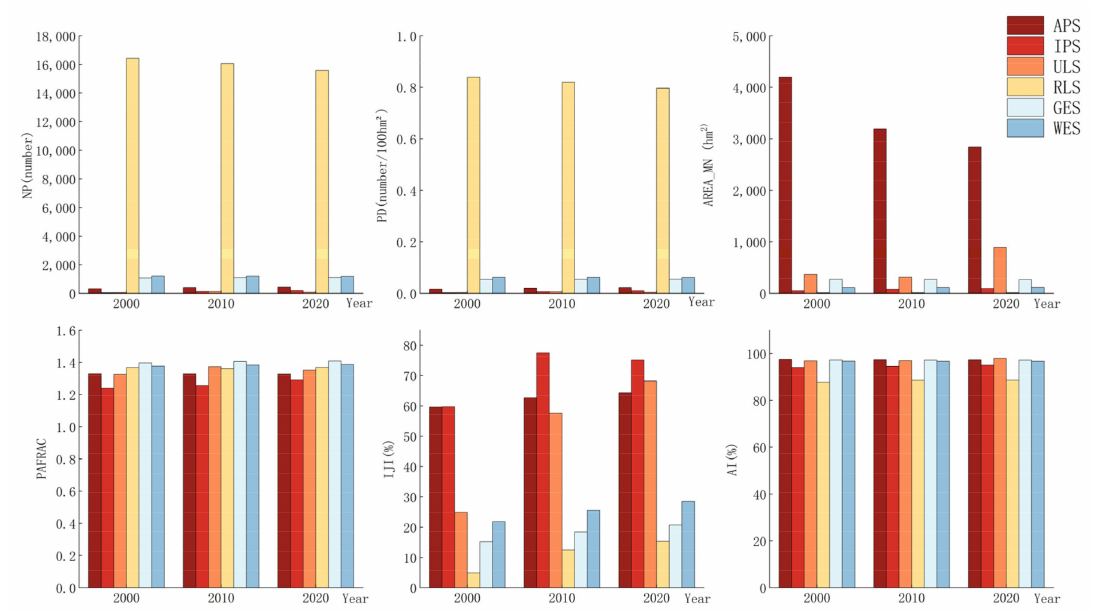
Figure 8. Type Level Index of Chaohu Lake Basin from year 2000 to 2020.